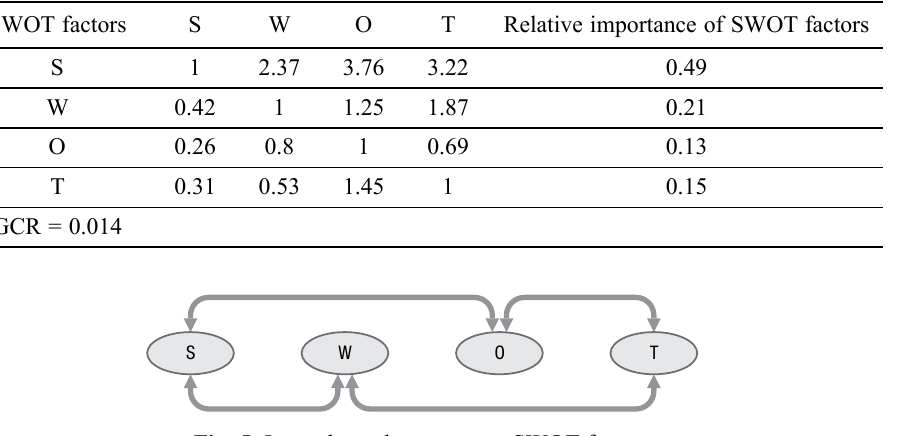
Fig. 5. Inner dependence among SWOT factors